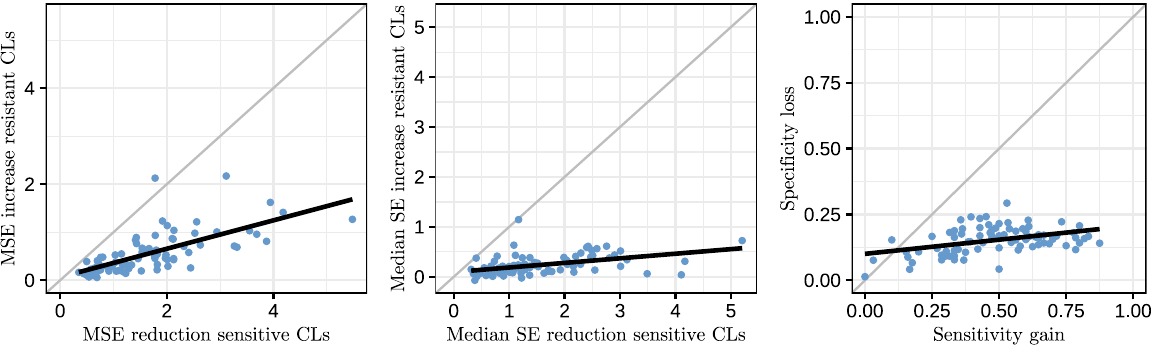
Figure 3. Random forest test set performance. In ( A ), we compare regression random forests (rRF), classification random forests (cRF), and HARF SR with different versions of our suggested approach SAURON-RF. We show the average test set performance across the 86 different drugs for 20 input features. Results for additional versions of SAURON-RF and other input feature set sizes can be found in the Supplementary Material (cf. Supplementary Figs. 12–18). In ( B ), we depict for each of the 86 drugs the tradeoff between the absolute reduction in test error for the sensitive cell lines and the absolute increase in test error for the resistant cell lines when comparing our best-performing version of SAURON-RF (SAURON-RF simple s.w., binary sens. t.w.) with